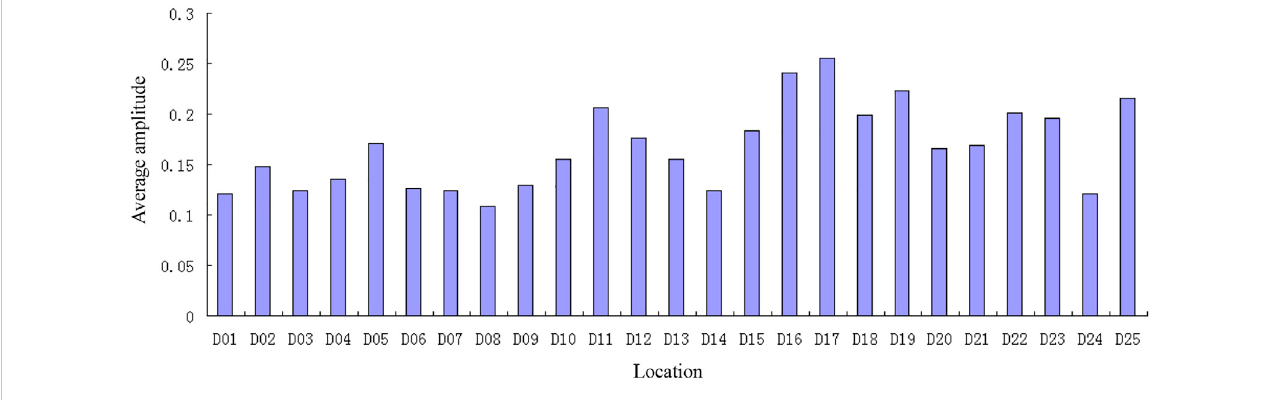
FIGURE 3 Average amplitude of station